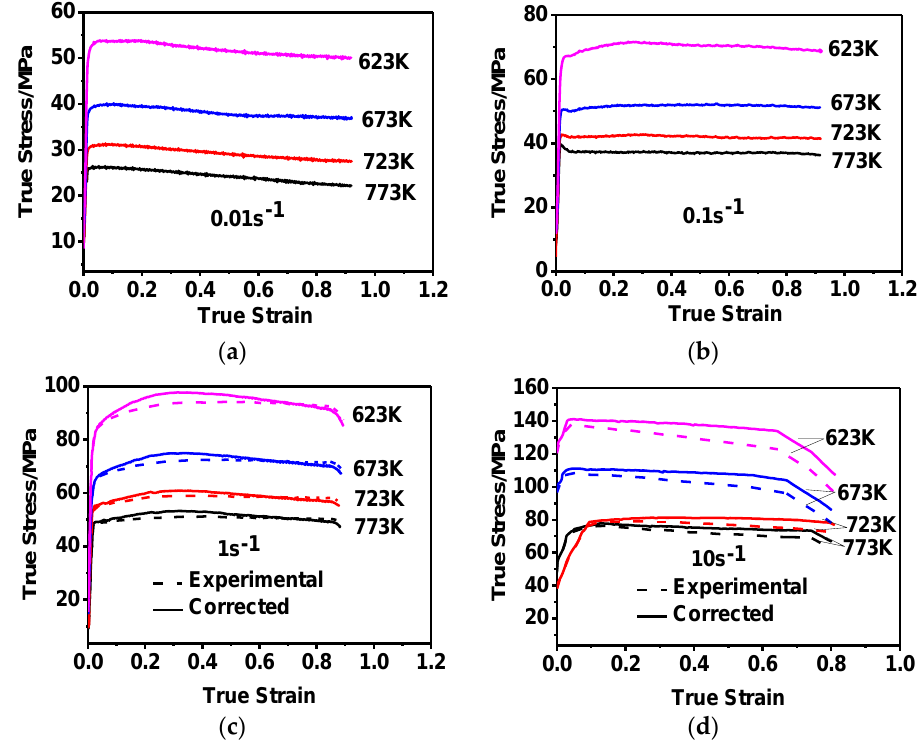
Figure 2. The true strain-stress curves obtained at various strain rates and temperatures of ( a ) 0.01 s −1 ; ( b ) 0.1 s −1 ; ( c ) 1 s −1 ; ( d ) 10 s −1 .